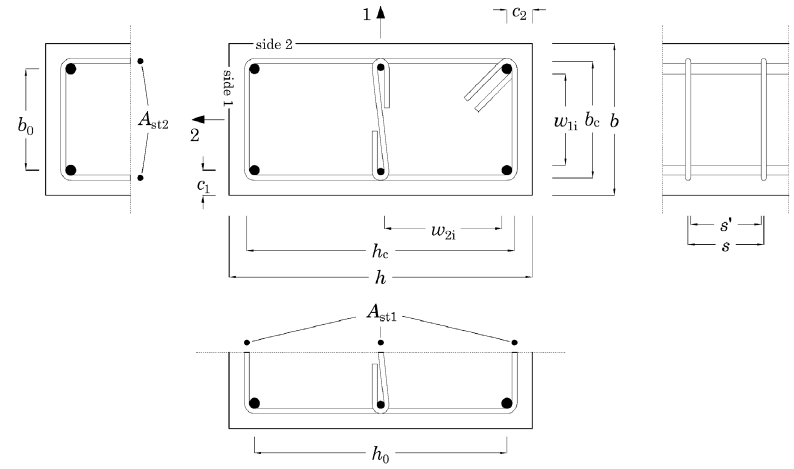
Figure 1. Symbols used for the description of the confinement mechanism.